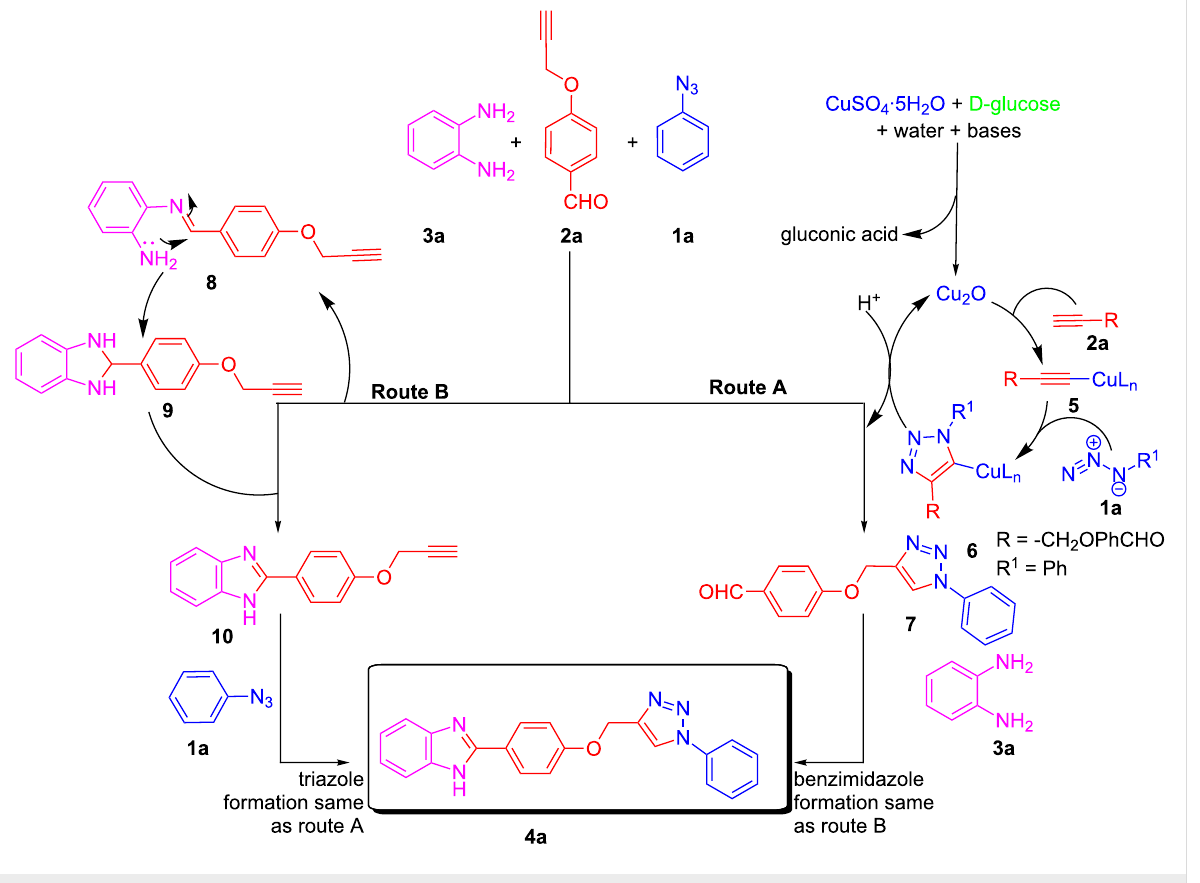
Scheme 2: Plausible mechanism for the synthesis of 2-(4-((1-phenyl-1 H -1,2,3-triazol-4-yl)methoxy)phenyl)-1 H -benzo[ d ]imidazole.